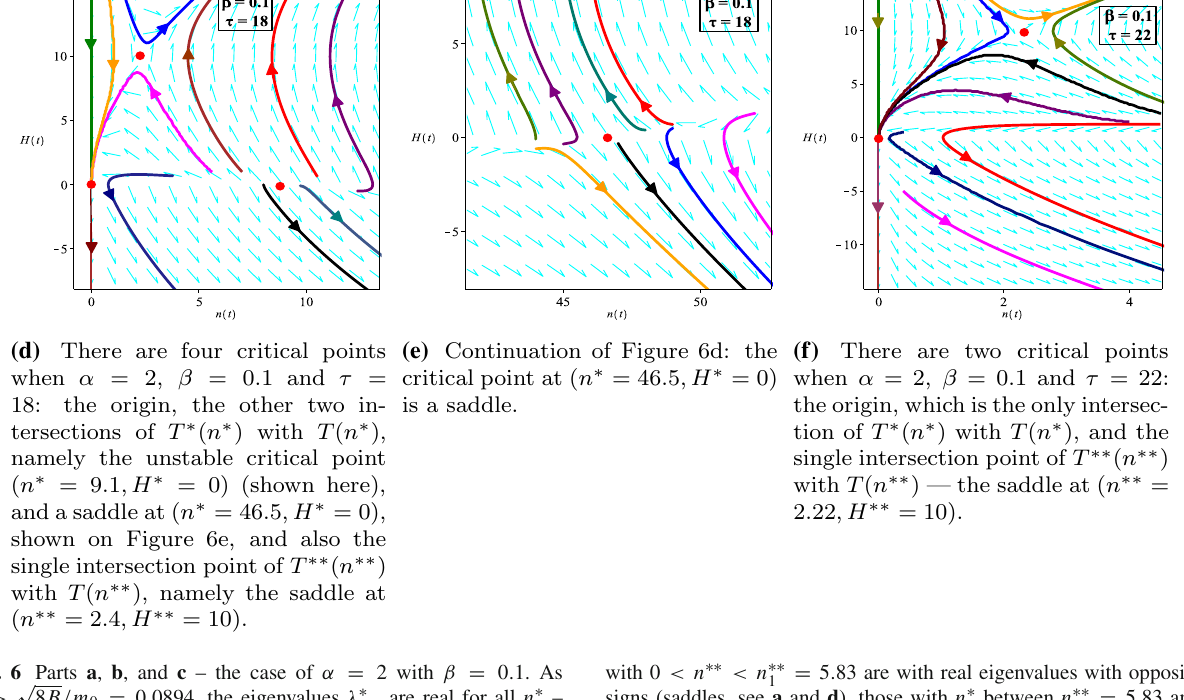
Fig. 6 Parts a , b , and c – the case of α = 2 with β = 0 . 1. As √ β > 8 B / m 0 = 0 . 0894, the eigenvalues λ ∗ are real for all n ∗ – √ 1 , 2 they are both positive for 0 < n ∗ < ( 3 / 2 − 1 )/ A = 22 . 47 (with the corresponding critical points being unstable nodes, see a and d ) √ and positive and negative for n ∗ > ( 3 / 2 − 1 )/ A = 22 . 47 (with the corresponding critical points being saddles, see b , e ). In relation to the = 5 . 83 and n ∗∗ = 72 . 02. Critical points eigenvalues λ ∗∗ , one has n ∗∗ 1 , 2 1 2